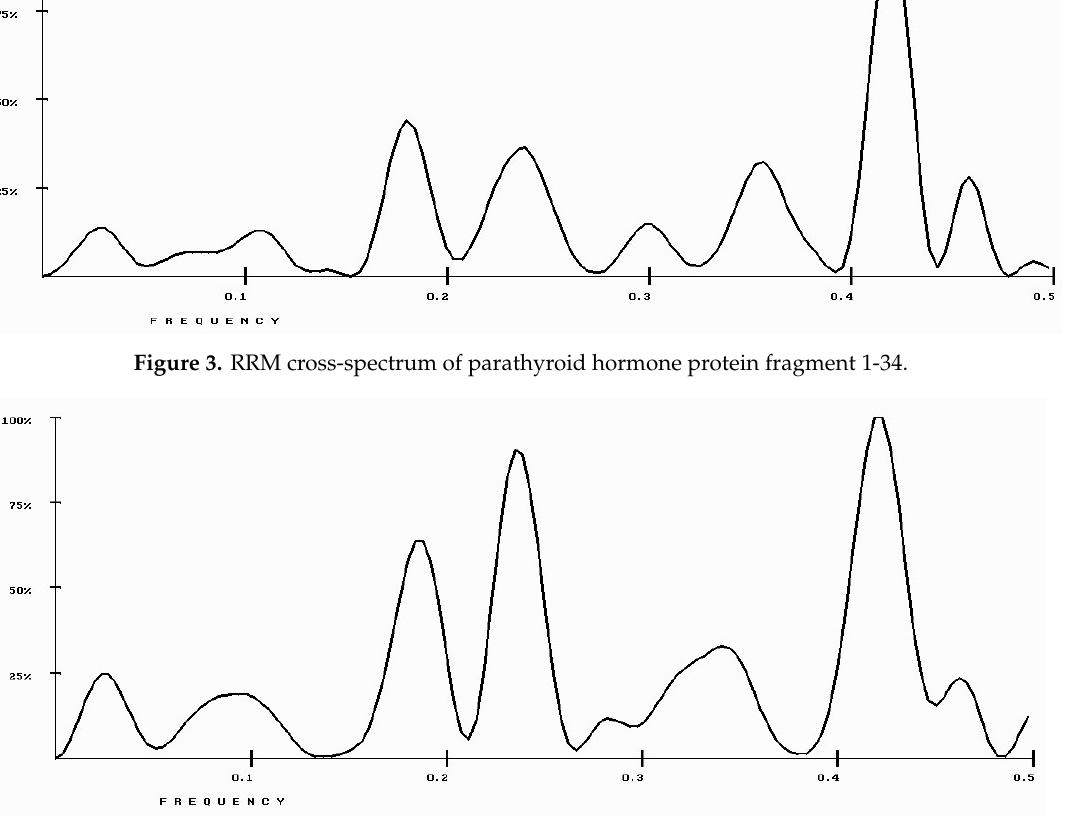
Figure 4. RRM cross-spectrum of parathyroid hormone protein fragment 7-34.